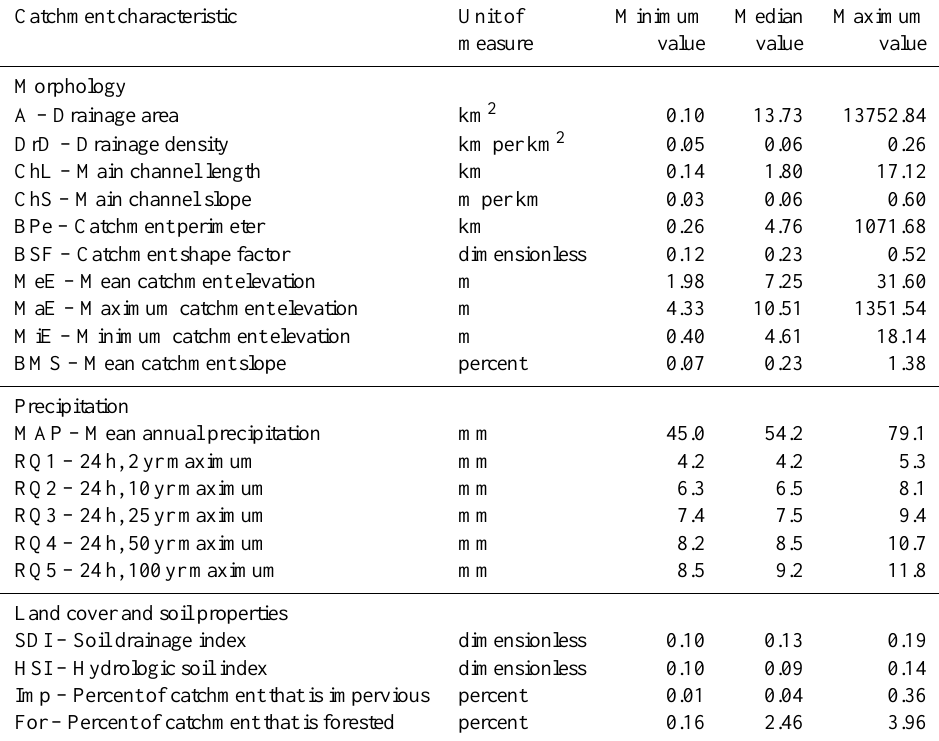
Table 1. Catchment characteristics describing the morphology, climate, land cover and soil properties of the contributing areas to the 61 study streamgauges (Gotvald et al., 2009). Where applicable, catchment characteristics were computed as an average over the drainage